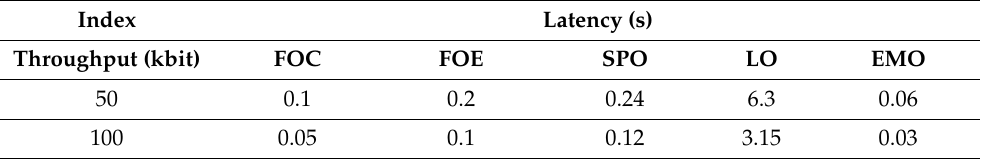
Table 3. Comparison analysis table of throughput and latency metrics.